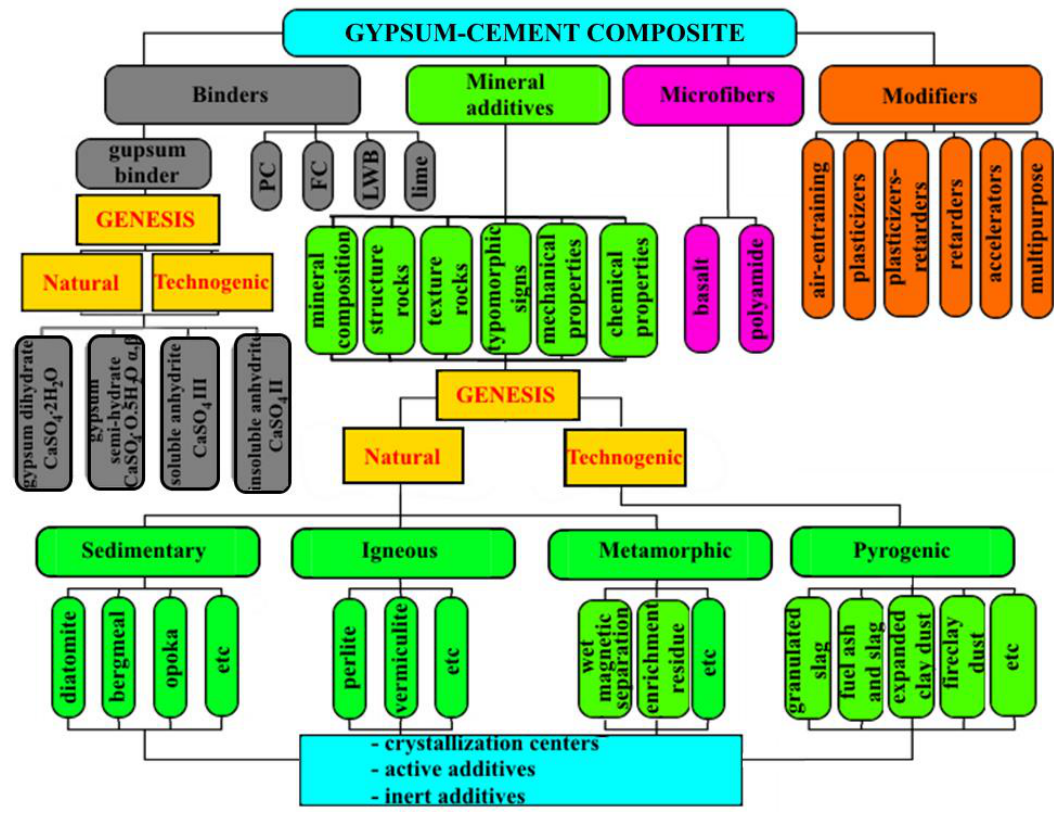
Figure 1. Classification of raw materials for the production of gypsum-cement binders (GCB) [25–28].